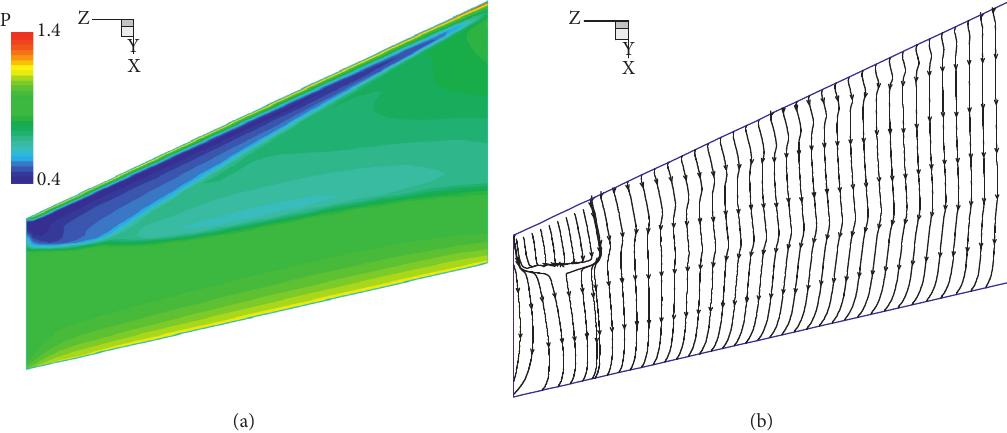
Figure 13: Pressure contours and streamlines with WENO-NZ scheme on the upper surface for ONERA-M6 wing. (a) Pressure contours. (b)